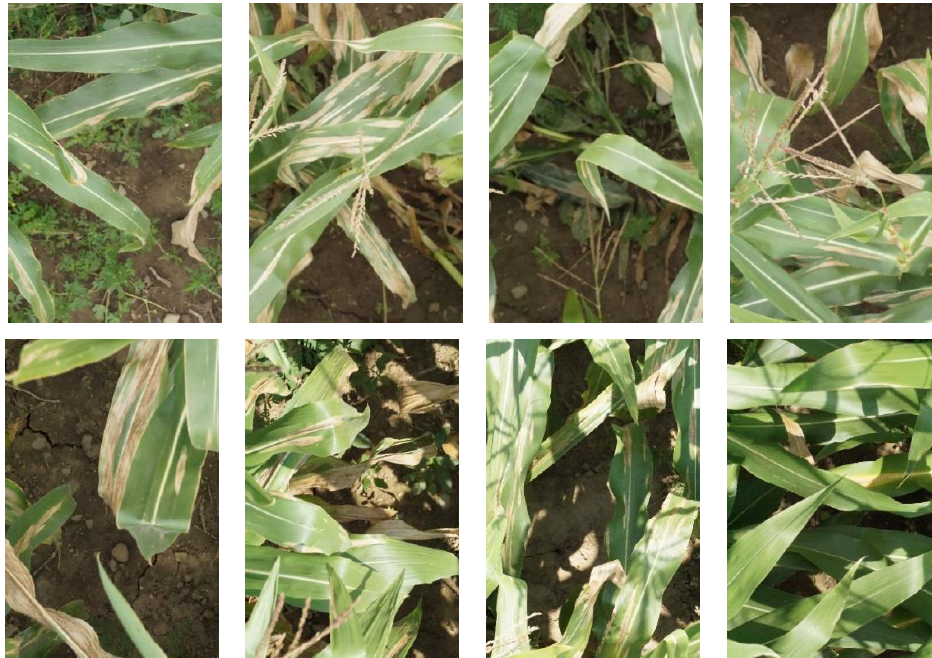
Figure 1. Examples of maize images collected by the UAV.